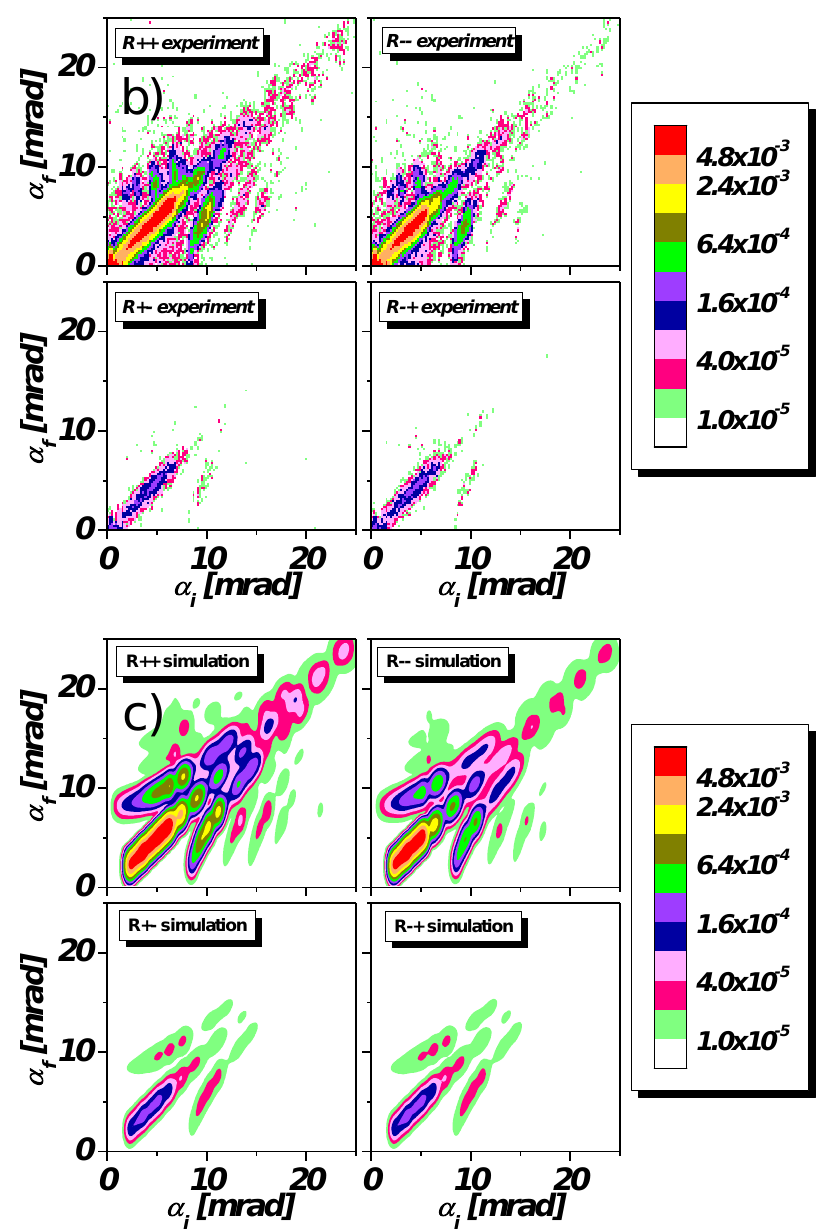
Figure 7. ( a ) NSF and SF specular reflectivities with least square fit from 800 Å thick permalloy stripe array with stripes oriented perpendicular to the scattering plane and in a field of H ext = 5.2 kOe applied along the stripes. ( b ) Off-specular scattering maps collected simultaneously with the specular reflectivities using a wide-angle multichannel spin analyzer. ( c ) Corresponding model calculations. Figure 8 represents fitted specular reflectivities and off-specular scattering maps collected from the sample with stripes oriented parallel to the scattering plane as sketched in Figure 5b. During these measurements, an external field of 5.2 kOe was applied perpendicular to the stripe array. The specular reflectivity scans in panel (a) show again a splitting between the NSF reflectivities R ++ and R −− and negligible SF reflectivities R + − and R − + on the 1% level. In the plateau region below the critical edge for the permalloy, a dip can be seen, which is due to the total reflection from the bare Si substrate, probed by coherence ellipsoids in the inter-stripe